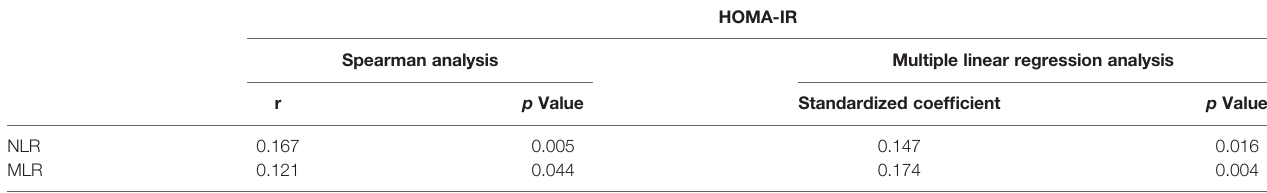
TABLE 2 | Association of HOMA-IR index with NLR and